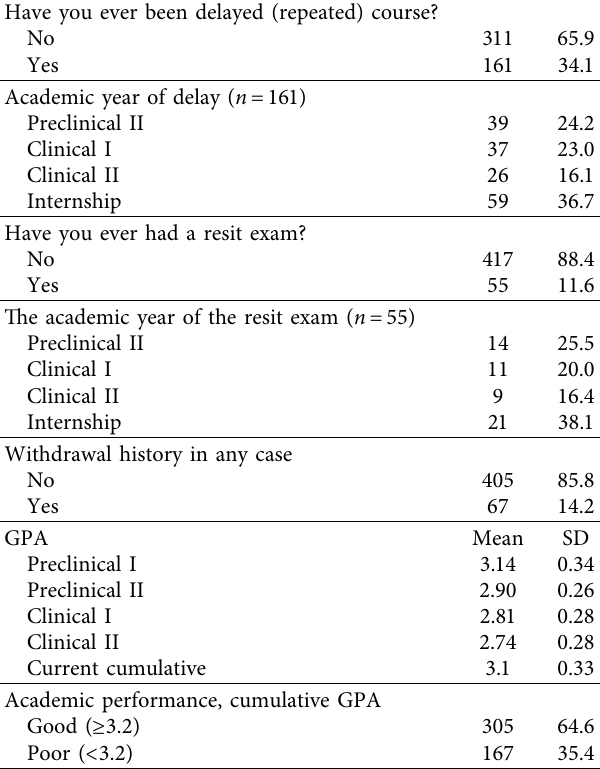
Table 3: Patterns of academic performance among new medical education system students in